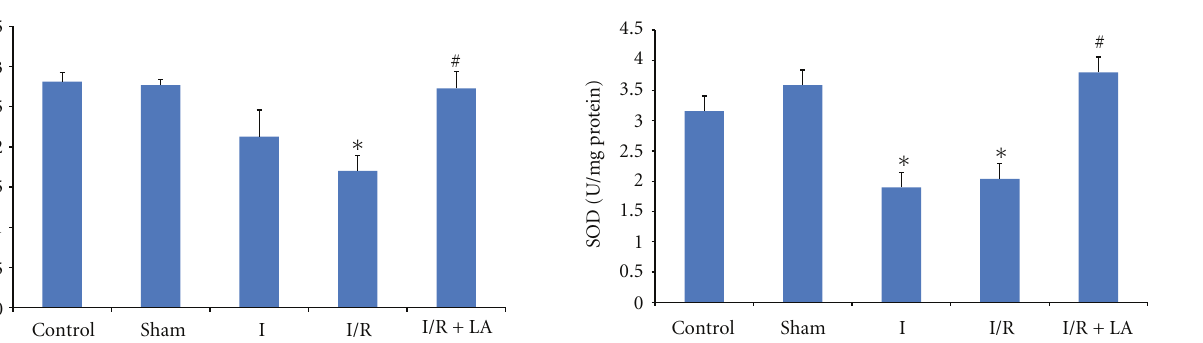
Figure 1: E ff ects of ischemia/reperfusion (2h torsion 720 ◦ in a clockwise direction and 2h detorsion of the testis) and LA (100mg/kg ip, 30 minutes prior to detorsion) on GPx levels of rat testes. Data are mean ± SEM: ∗ P < 0 . 05 compared with control and sham groups, # P < 0 . 05 compared with I/R group.